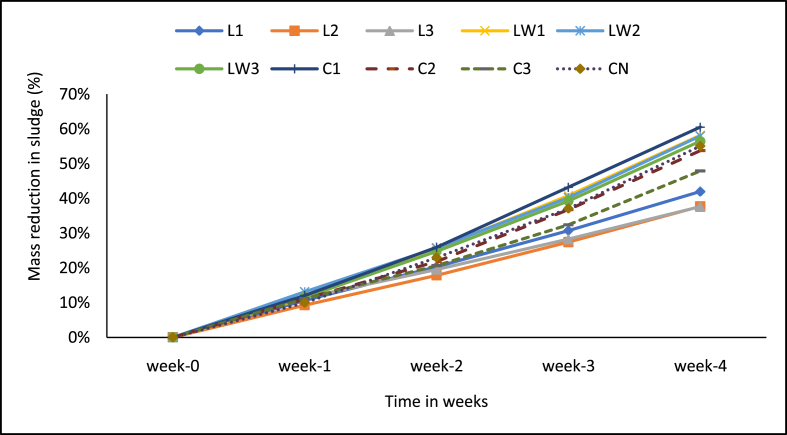
Percentage mass loss in sludge samples. Note: L1 = 25 mL stock LSEC, L2 = 50 mL stock LSEC, L3 = 75 mL stock LSEC, LW1 = 0.1% DF, LW2 = 0.5% DF, LW3 = 1% DF, C1 = 5 g calcium carbide, C2 = 8 g calcium carbide, C3 = 10 g calcium carbide, CN = control.